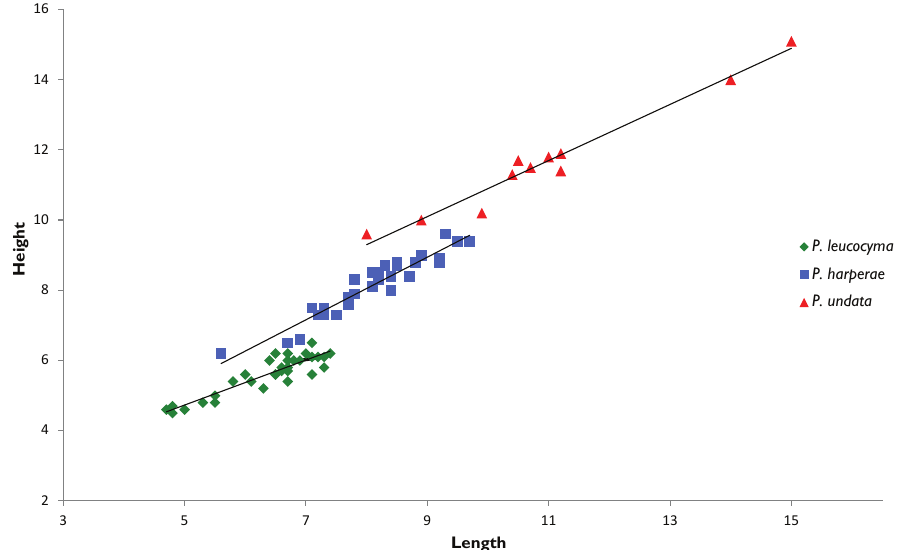
Figure 8. Bivariate height/length plots comparing P. harperae with P. leucocyma , and P. undata. Length and height in